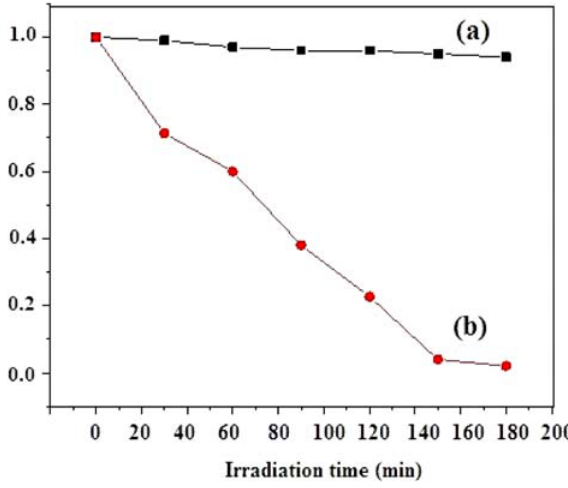
Figure 5b. Kinetics of photodegradation of (a) Pure MB and